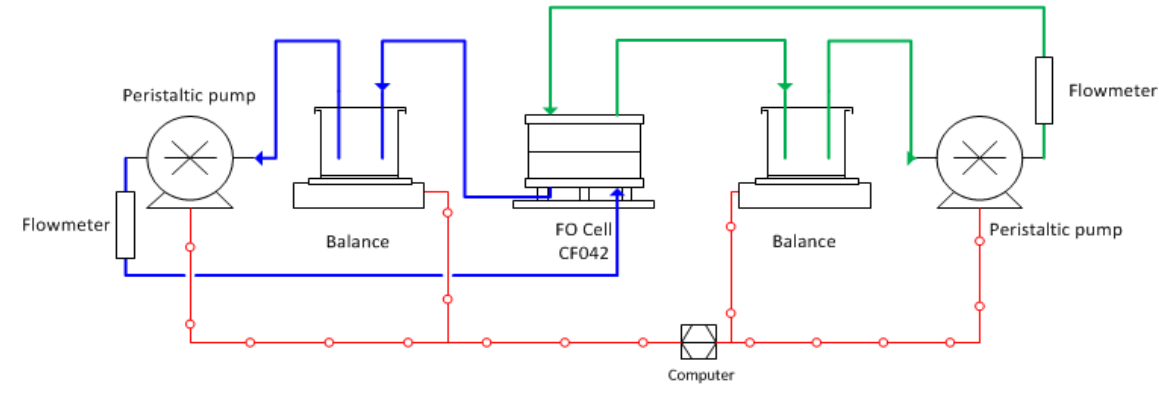
Figure 9. Schematic diagram of bench-scale FO test